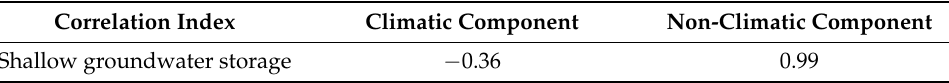
Table 1. Correlation analysis for climatic component and non-climatic component.